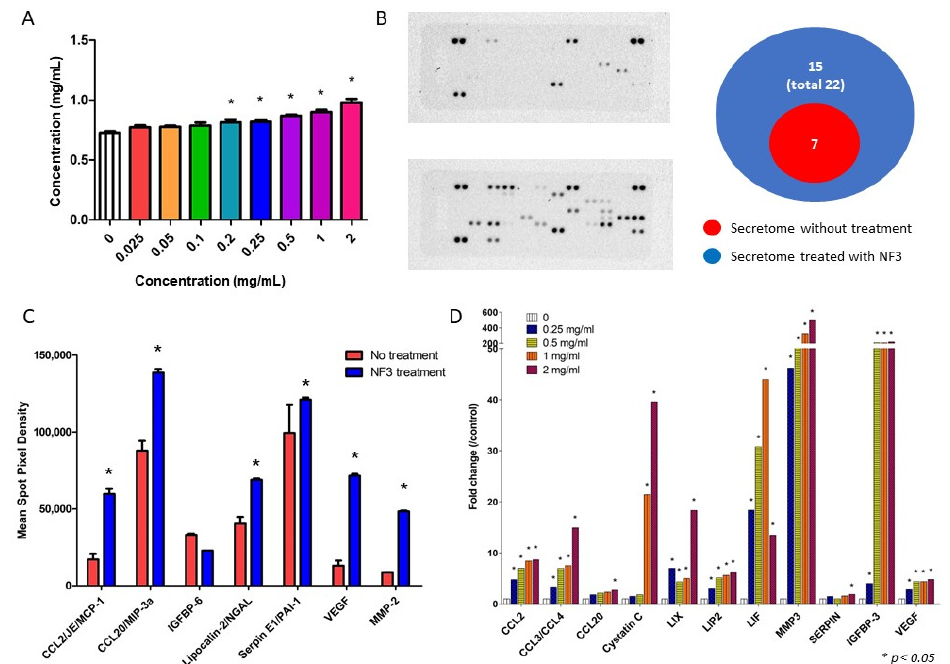
Figure 6. Results of protein array. A total of 79 proteins were examined in the supernatants of MSCs with or without NF3 treatment. ( A ) Total protein concentration. This indicated that after different doses of NF3 (0.2–2 mg/mL) treatment, the protein concentration in the supernatant was increased. ( B ) Results of Proteome Profiler Rat XL Cytokine Array. Left: an image of the membrane in the array. The upper image shows the untreated supernatant and the lower shows the NF3-treated superna- tant. As shown in the diagram on the right, there were seven proteins detected in the untreated supernatant, while twenty-two were detected in the NF3-treated supernatant. ( C ) Semi-quantitative analysis of the protein expression. The data showed that the expressions of the most common pro- teins (except for IGFBP-6) were upregulated after NF3 treatment. ( D ) RT-PCR validation. The ex- pressions of 22 proteins were validated by RT-PCR. The expressions were upregulated significantly after different doses of NF3 treatment (0.25–2 mg/mL) and presented in a dose-dependent manner. Table 1. List of proteins detected in the supernatants of MSCs. The upper section details the seven common proteins that existed in both NF3-treated and un-treated supernatant. The lower section details the 15 unique proteins detected only in NF3-treated supernatant. Their functions are related to inflammation, angiogenesis, ECM remodeling, apoptosis, and cell signaling. In terms of cell sig- naling, this includes cell adhesion, signal transduction, migration, proliferation, differentiation, se- nescence, etc. ECM Cell Inflammation Angiogenesis Apoptosis Remodelling Signalling